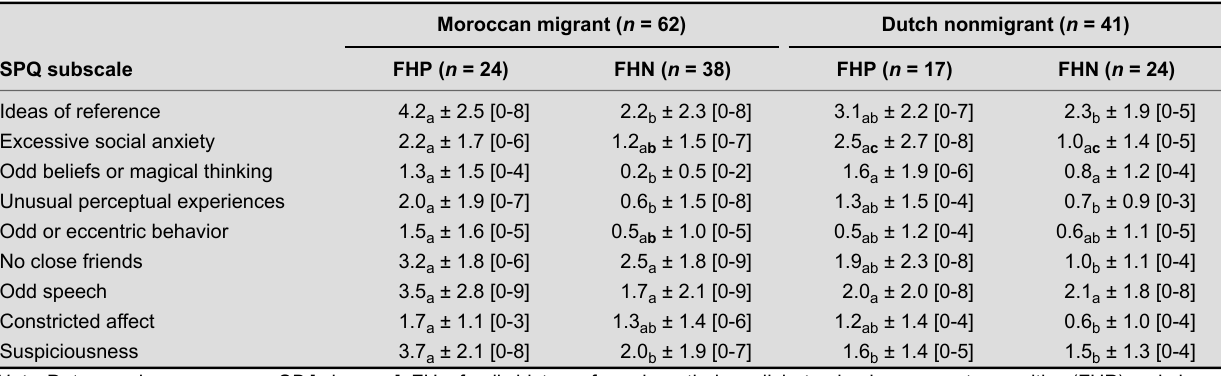
Schizotypal Personality Questionnaire Subscale Scores as a Function of Migration Status and Family History (N = 103)